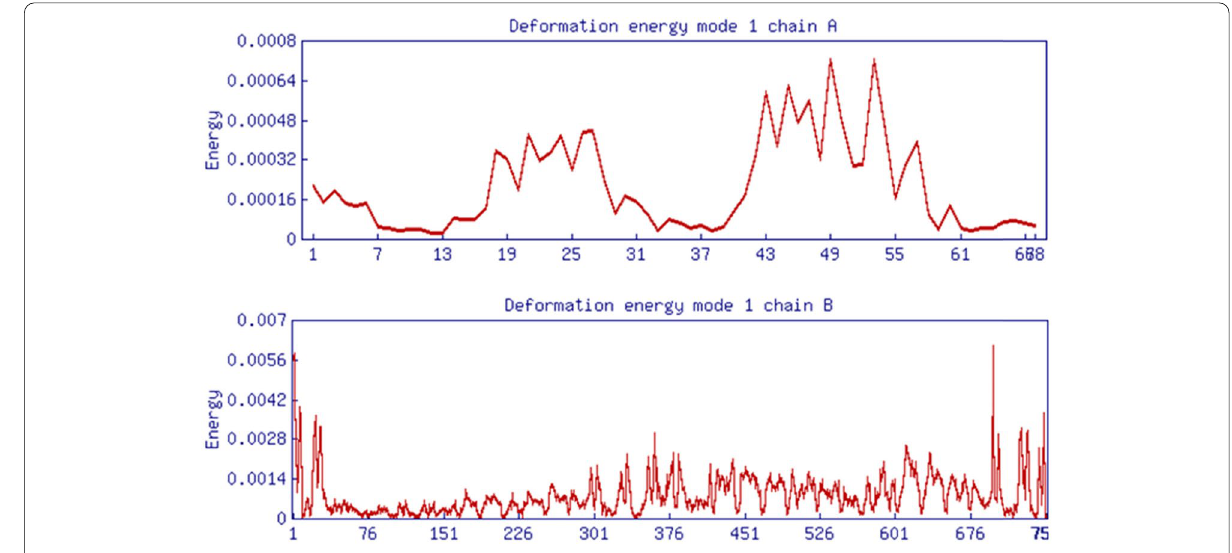
Fig. 10 Molecular dynamics of docked complex. Deformation